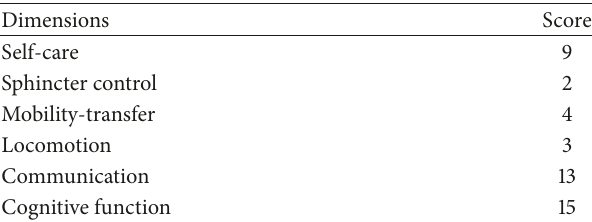
Table 2: First evaluation scores of Functional Independence Mea- sure (WeeFIM).